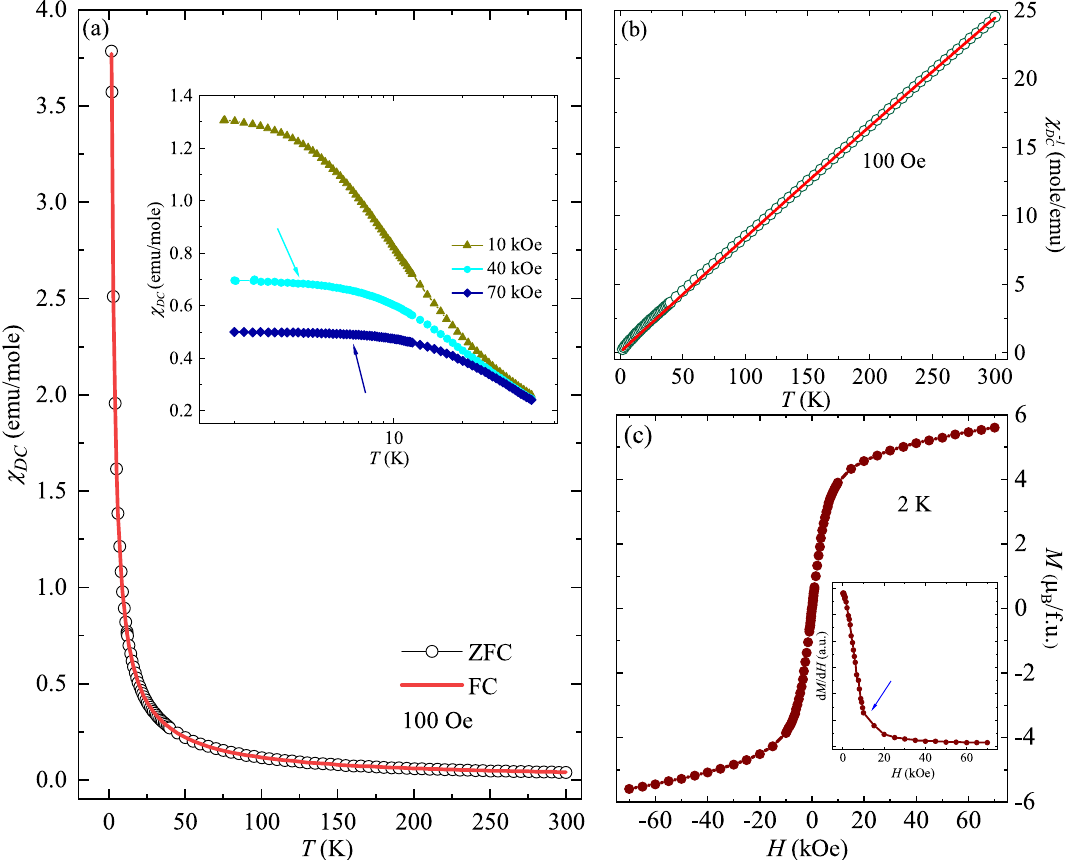
Figure 2. ( a ) χ DC as a function of T measured at 100 Oe under ZFC and FC protocols. The inset shows the same quantity measured at various applied H up to 70 kOe on the log scale. The arrows denote the onset of the 1 saturation. ( b ) T response of χ − DC at 100 Oe field. The solid red line denotes the fitting to the CW law (1). ( c ) Isothermal magnetization curve obtained at 2 K. Inset: H dependence of the derivative of the magnetization with respect to field at 2 K. The arrow indicates the slope change around 10